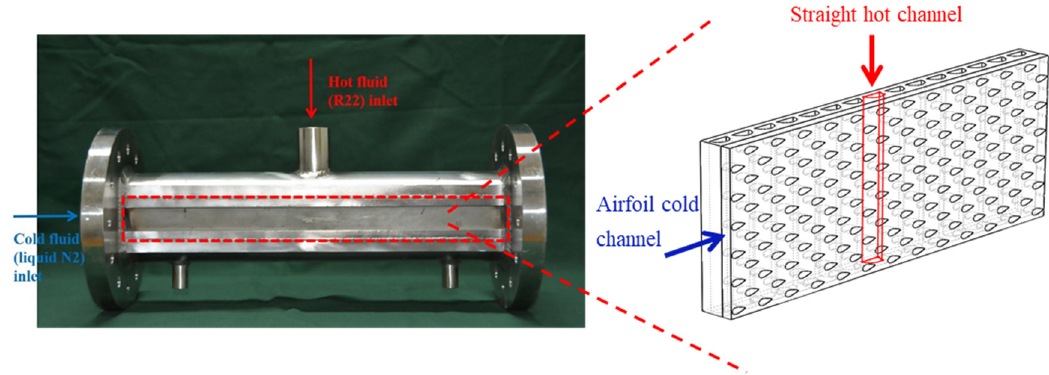
Figure 2. The tested Printed Circuit Heat Exchanger (PCHE) with diagram of the core structure. Table 1. Printed Circuit Heat Exchanger (PCHE) channel geometry.